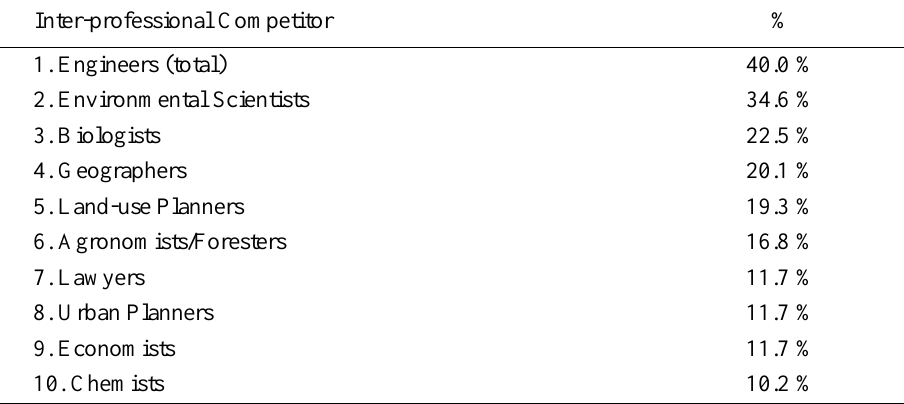
Most relevant inter-professional competitors (multiple responses allowed).